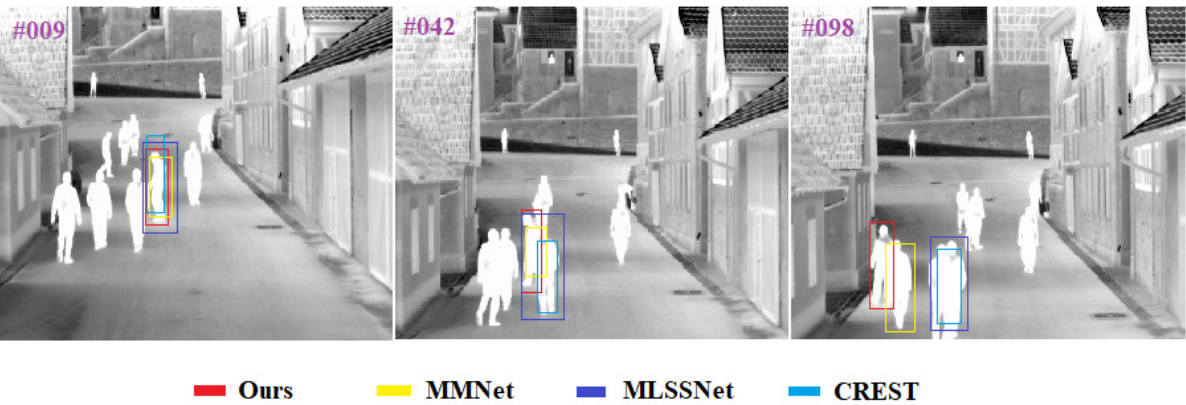
Figure 12. The visualization of tracking results in the sequence saturated.